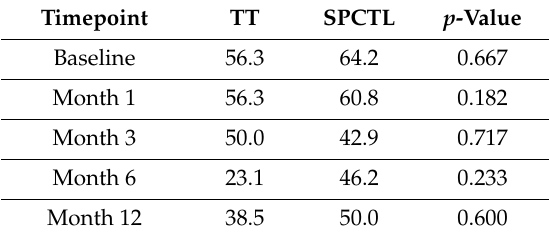
Table 6. Proportion of participants categorized as highly stressed based upon the perceived stress